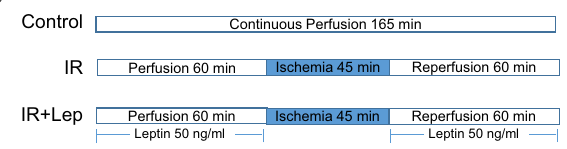
Fig. 1 Schematic representation of the experimental design. Hearts from the control group were continuously perfused with Krebs buffer; IR hearts were subjected to 45 min of ischemia before 60 min of perfusion and after 60 min of reperfusion; IR Lep hearts were + subjected to the same protocol as the IR group but the Krebs buffer contained 50 ng/mL leptin. IR ischemia–reperfusion; Lep leptin. For all experiments, n =